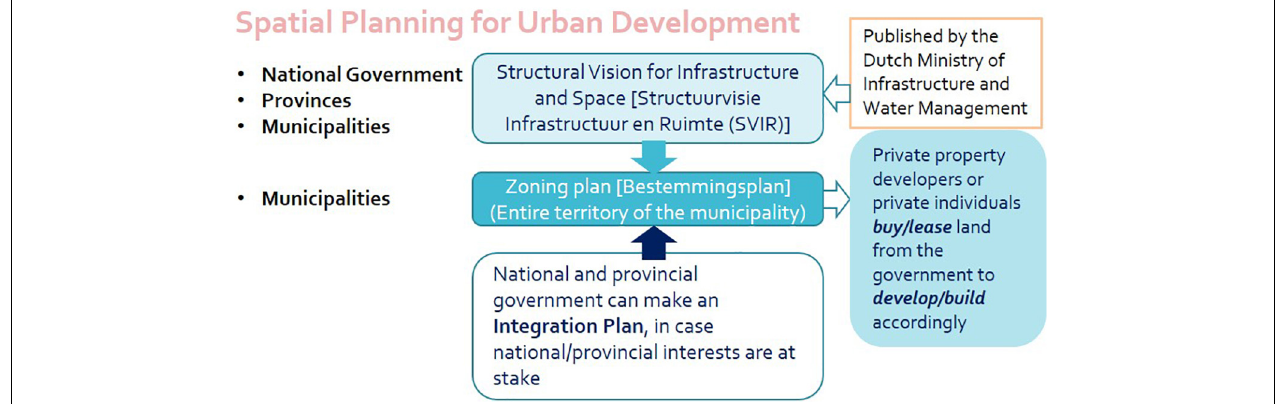
FIGURE 2 | The process of spatial planning for urban development come to being in the Netherlands. Land-use zoning plans allow for desired changes. In the face of increasing interests in floating development, the Municipality of Amsterdam, for instance, drafted a “Bestemmingsplan Drijvende Bouwwerken (Zoning Plan Floating Structures),” indicating a technical legal amendment to the Houseboat Clarification Regulations, which came into effect on January 1, 2018 (Gemeente Amsterdam, 2018). In the document, the Municipality of Amsterdam has assigned 59 prevailing zoning areas for building on water within the city of Amsterdam. In 2019, the Municipality of Amsterdam announced “Vaststelling paraplubestemmingsplan Drijvende Bouwwerken” (The Adoption of the Umbrella Zoning Plan Floating Structures), expressing that an umbrella zoning plan with an updated framework has been introduced to assess applications for environmental permits for the building activities regarding floating structures. This was necessary to optimize the evaluation process (Gemeente Amsterdam, 2019). It can be observed that there have been ongoing efforts from the local government to consider development on water in its zoning plans.